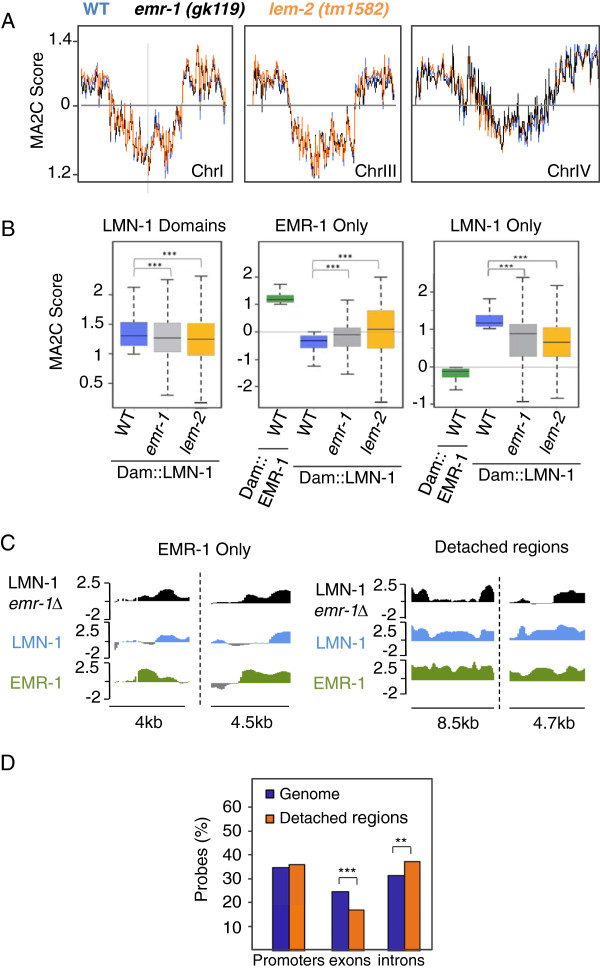
Mutations in emr-1 or lem-2 produce local changes in nuclear organization. (A) Comparison of the regions enriched for Dam::LMN-1 signals in chromosomes I, III and IV in wild type (WT, blue), emr-1(gk119) (black) or lem-2(tm1582) (orange) nematodes (100-kb window MA2C score). (B) Boxplots (as in Figure 1) of Dam::LMN-1 MA2C scores at probe level in LADs, ‘EMR-1 only’ or ‘LMN-1 only’ elements in wild type, emr-1(gk119) or lem-2(tm1582) nematodes. Dam::EMR-1 MA2C scores are included in the middle and right panels to illustrate the mutually exclusive association of ‘EMR-1 only’ and ‘LMN-1 only’ elements with EMR-1 and LMN-1 (***P < 10-11, Wilcoxon rank sum test). (C) Genome browser views of Dam::LMN-1 occupancy in wild type and emr-1(gk119) mutants. (D) Distribution of regions with reduced LMN-1 association in emr-1(gk119) mutants ('Detached regions') in promoters, introns and exons compared to the distribution of the genome. Probability values from one-sided binomial tests are indicated (**P < 10-4, ***P < 10-11).